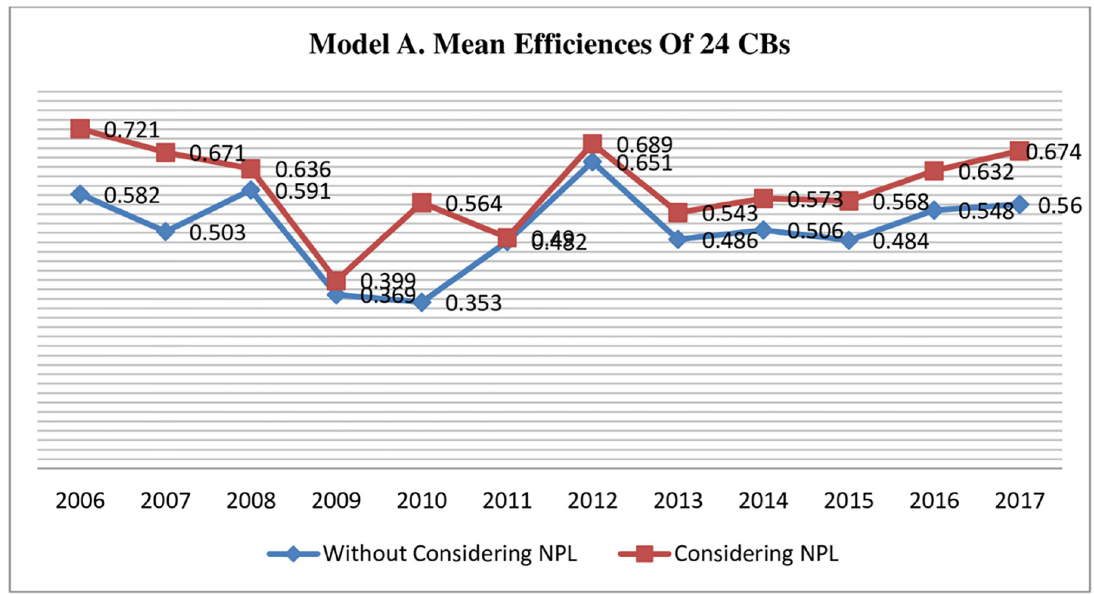
Fig 3. Model, A comparison of mean efficiency scores of all CBs, estimated with and without incorporating undesirable output NPLs.